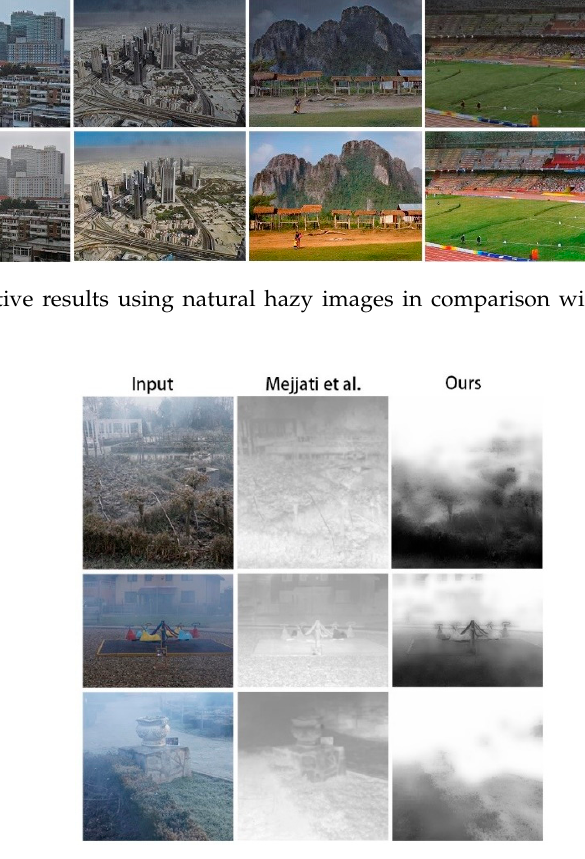
Figure 8. Results obtained with proposed attention map and that using the method of Mejjati et al. [26] through training of the network.